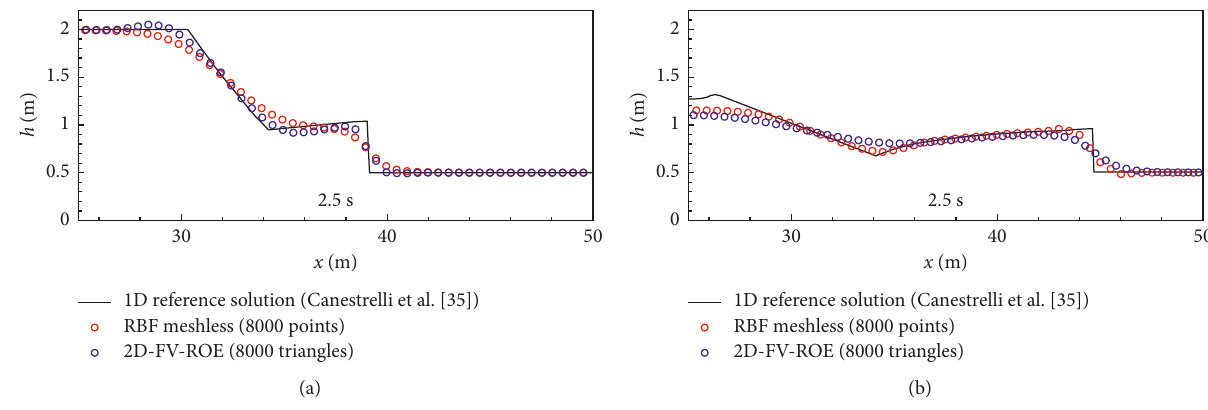
1s and t 2.5s. (cid:29) (cid:29)